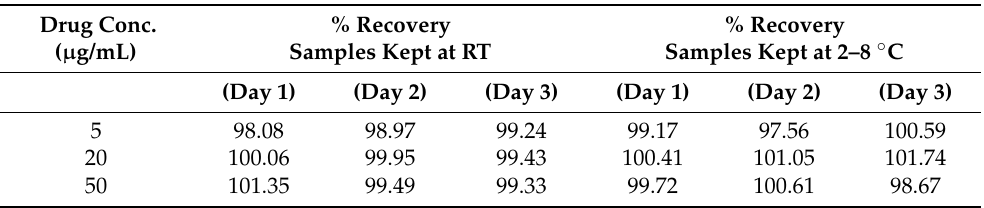
Table 2. Percent recovery studies for stability samples kept at room temperature (RT) and refrigerator (2–8 ◦ C).